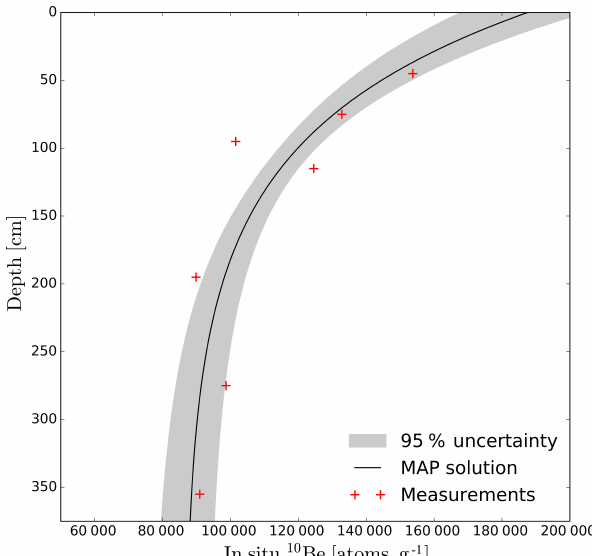
Figure 11. 95% predictive uncertainty interval (gray area) and as- sociated MAP prediction (black line) derived using the Bayesian ap- proach taken in the CRONUScalc program. The red crosses repre- sent the seven measurement data points used in the inversion. Depth is given in absolute depth.